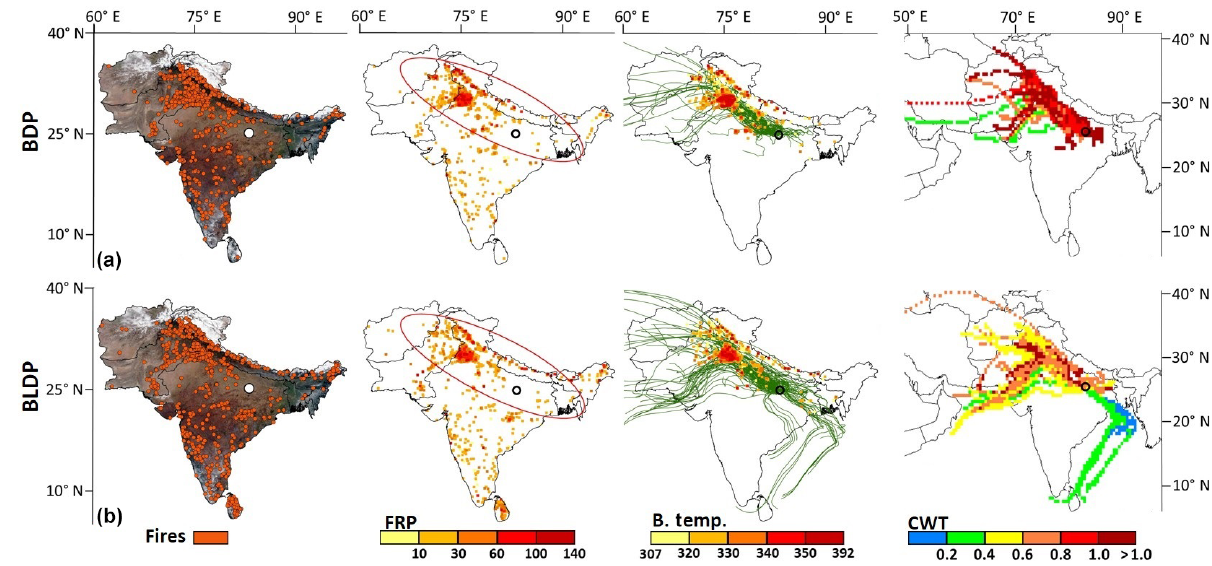
Figure 9. Episode-specific MODIS fire count, fire radiative power (FRP, MW), brightness temperature (B. temp., K), and 5-day air mass back trajectory along with CWT.